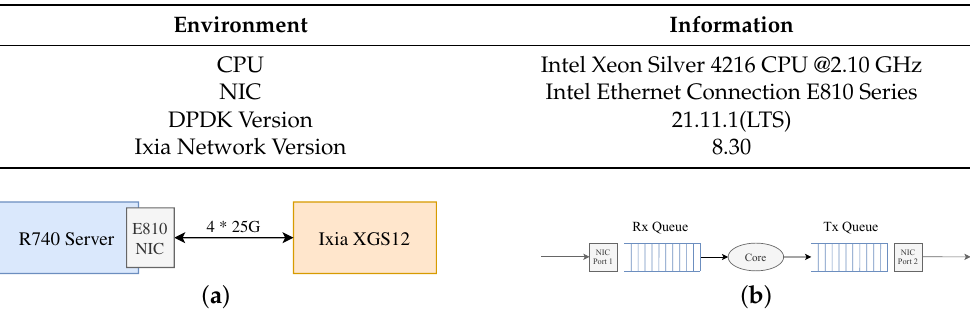
Figure 3. The experimental configurations. ( a ) The testbed topology. ( b ) The queue